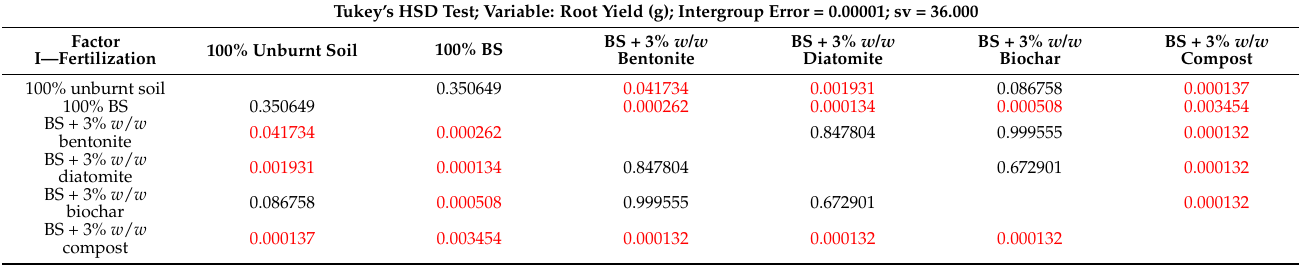
Table A2. Underground biomass yield—effect of fertilization; significant differences are shown in